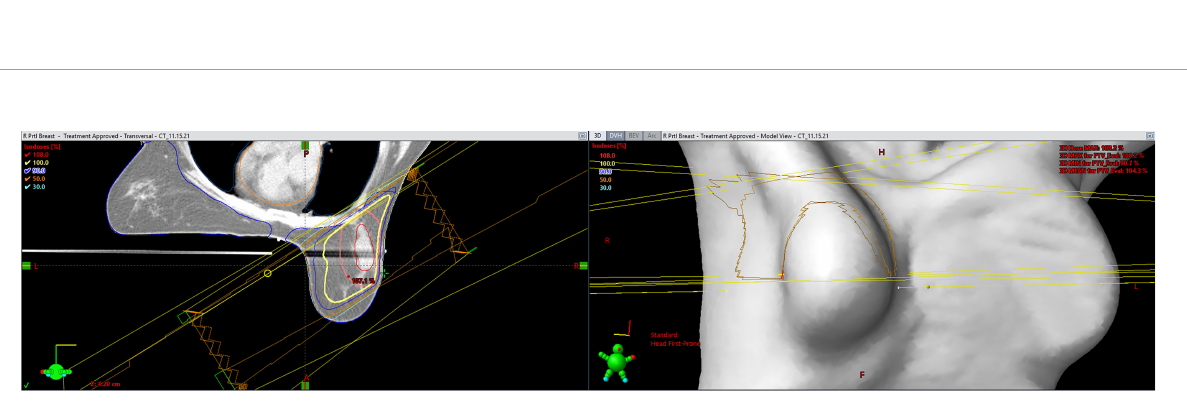
FIGURE 2 A representation of a typical external beam accelerated partial breast irradiation (APBI) plan in the prone position (Eclipse; Varian Medical Systems, Palo Alto, CA).